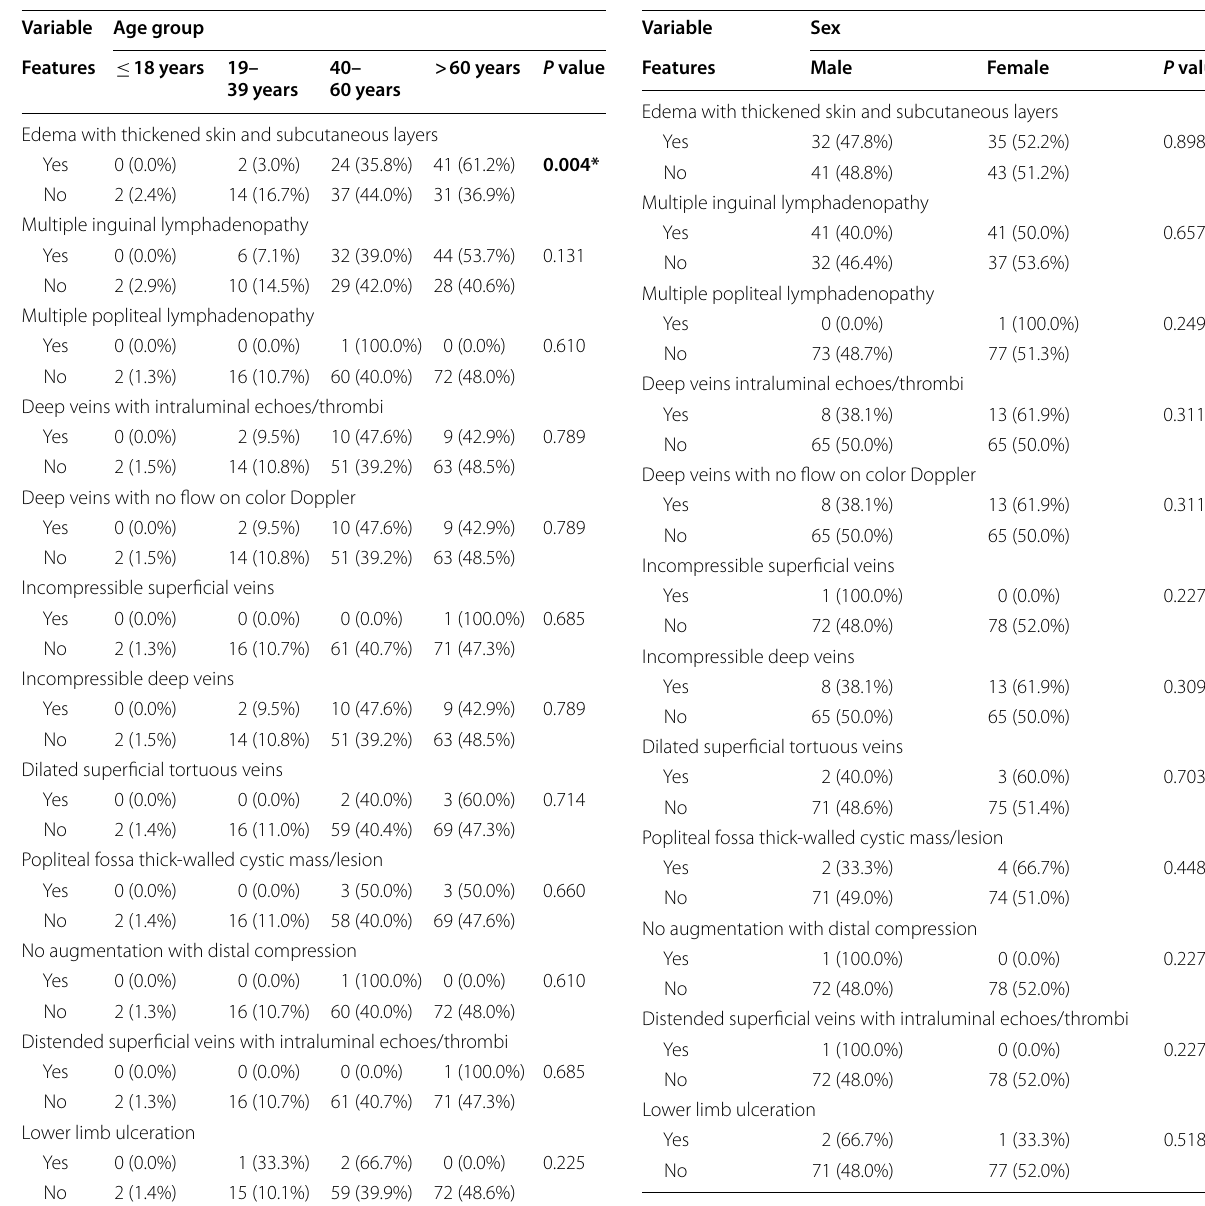
Table 3 Distribution showing the relationship between age and Table 4 Gender distribution of ultrasound features of